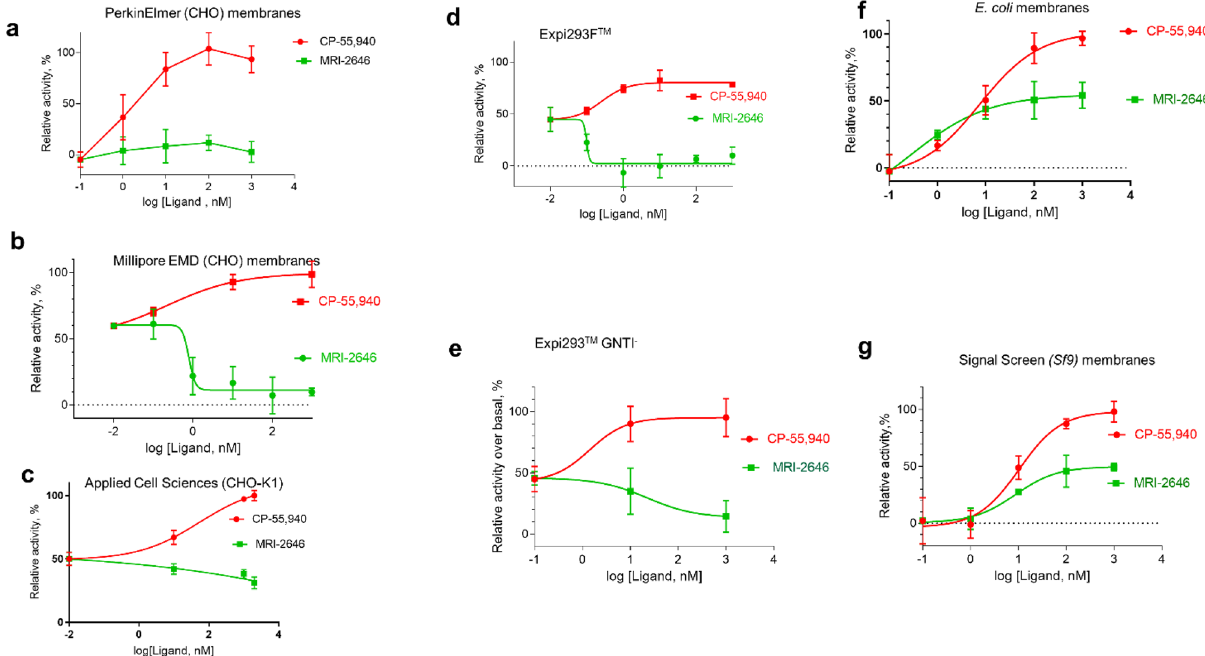
Figure 4. GEF on CB 2 expressed in different cell lines. An amount of 2 μg of membrane protein per assay was used. Each data points represents an average of four independent measurements (n = 4) with error rates indicated by the bars. 100% represents full activation in the presence of 2 μM of CP-55,940, and 0%–with 2 μM